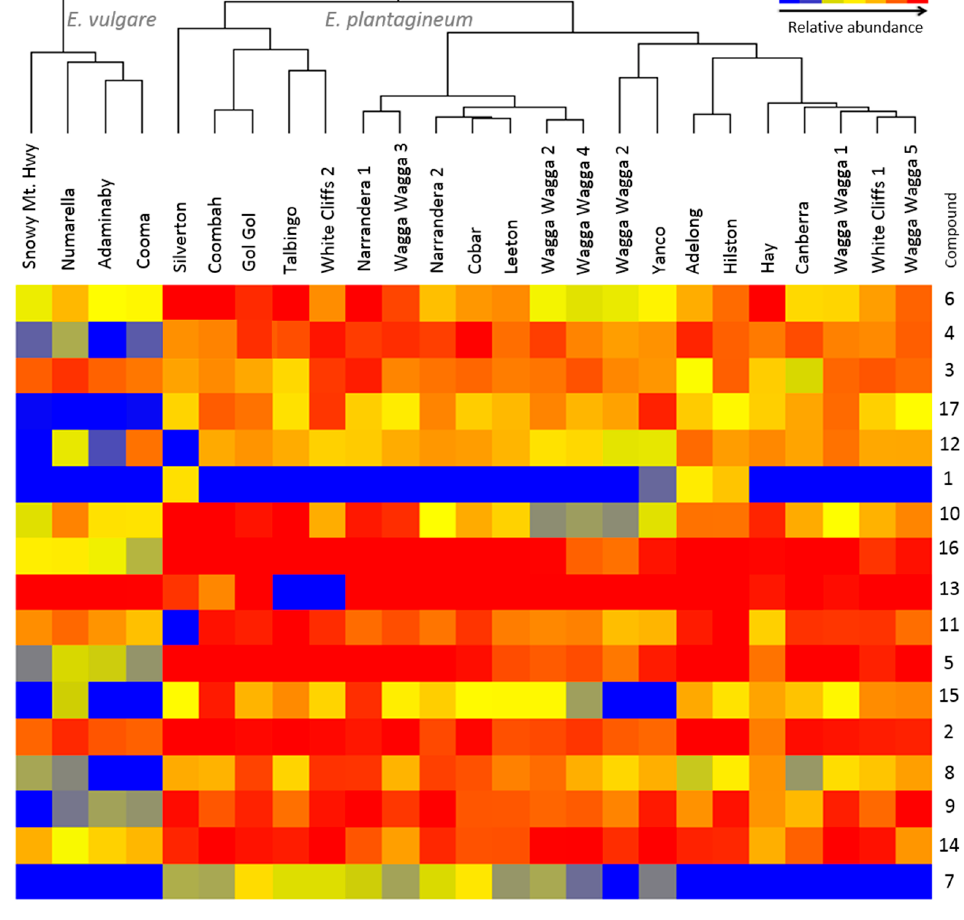
Figure 3. Variation in abundance of 17 pyrrolizidine alkaloids and their N -oxides (Table 1) in composite, field-collected samples of Echium plantagineum and E. vulgare . Hierarchical clustering algorithm and Euclidean distance metric were used on normalized abundance values. Dendrogram was generated using Mass Profiler Professional software (Agilent, Santa Clara, CA, USA).